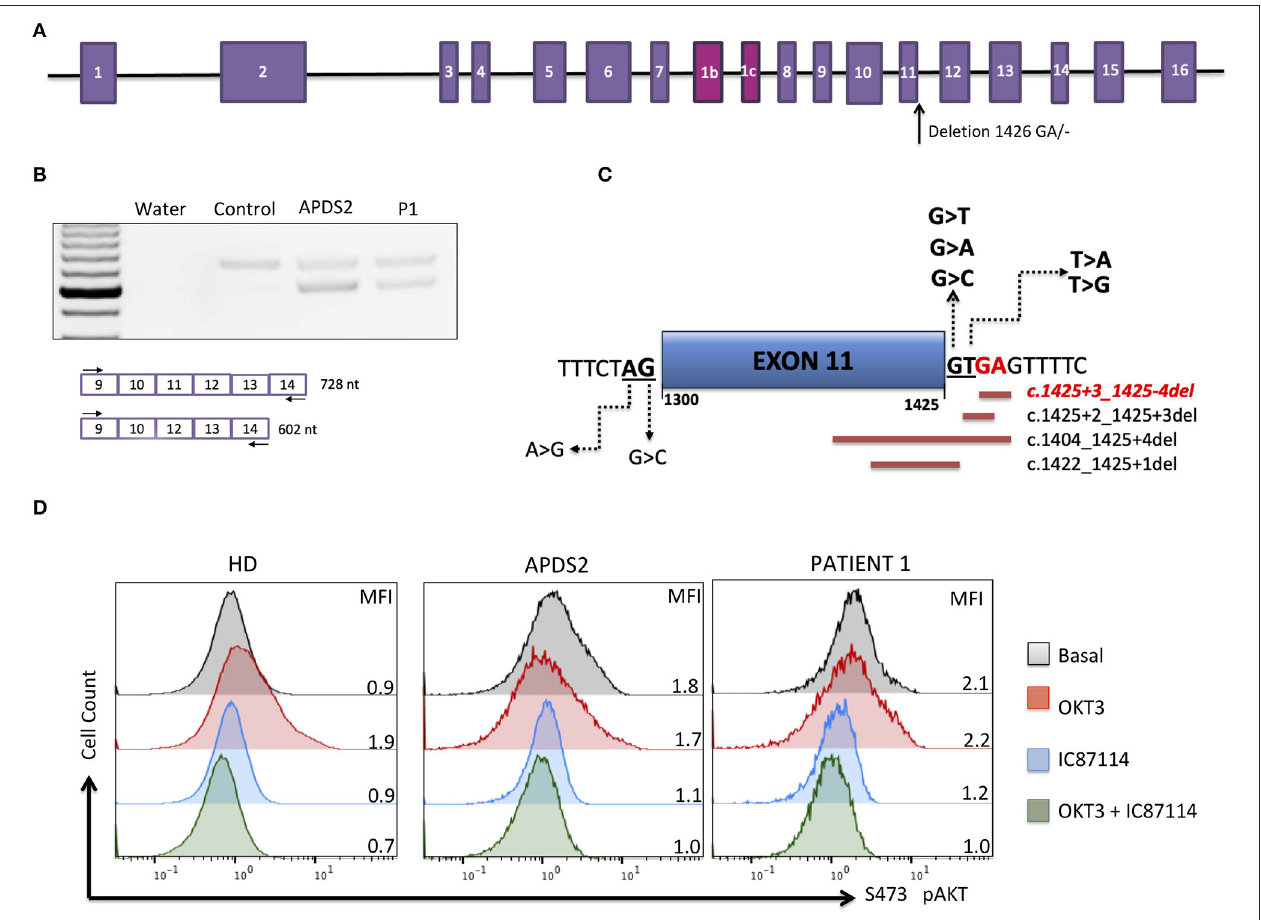
FIGURE 1 | Molecular APDS2 characteristics. (A) Schematic representation of the PIK3R1 gene and illustrated localization of identified mutation. (B) RT-PCR of PIK3R1 mRNA from T-cell blast of a control, a patient with APDS2 ( 3), and the investigated patient. (C) Schematic representation of mutations affecting splicing of exon 11 annotated in ClinVAR. In red is the mutation of investigated patient. (D) AKT phosphorylation analysis in T-cell blasts (cultured for 13 days) from a healthy control, an APDS2 patient, and the investigated patient. The analysis was performed as described by Deau et al. ( 3). Mean fluorescence intensity (MFI) is indicated for each